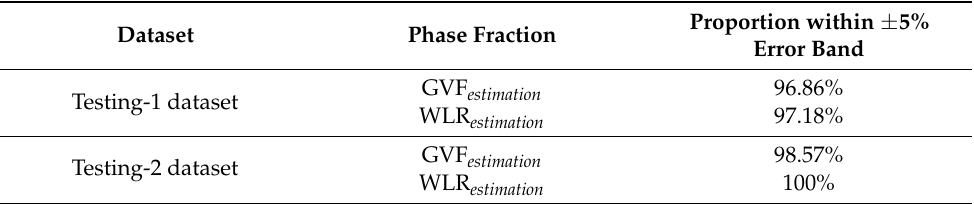
Figure 8. The estimation of GVF and WLR with the prediction results on the testing-1 and testing-2 datasets obtained by the proposed CNN-based model. ( a ) The estimation of GVF; ( b ) The estimation of WLR. Table 11. Proportion within ± 5% error band for GVF and WLR estimation on the testing-1 and testing-2